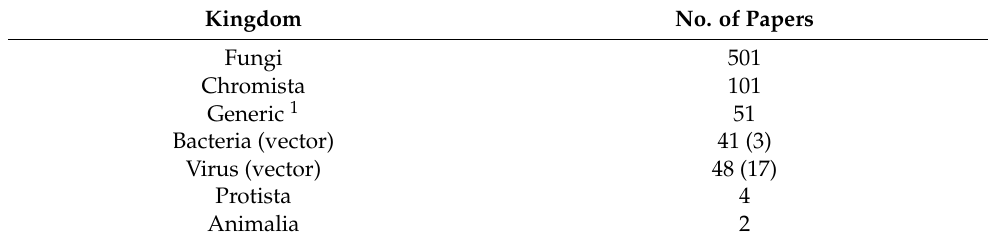
Table 4. Number of papers recorded for each kingdom.